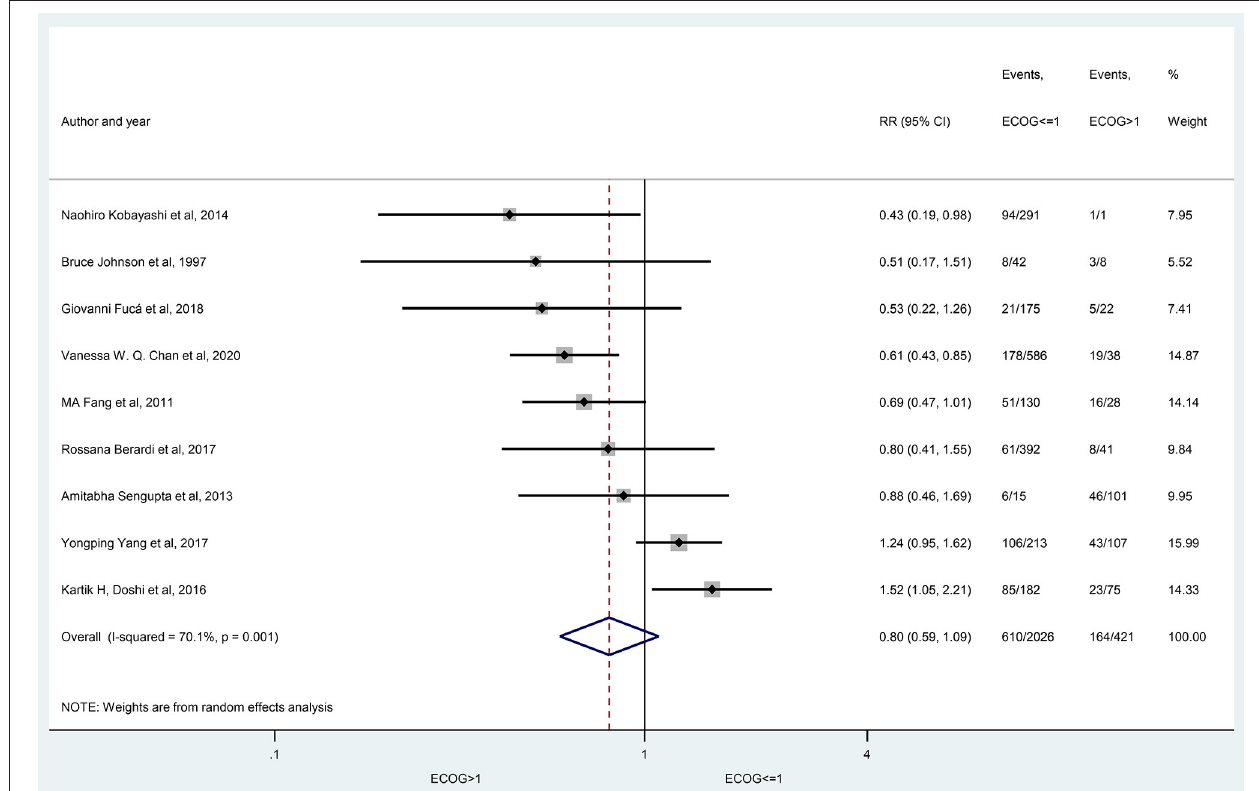
FIGURE 5 | The prevalence of hyponatremia in patients with lung cancer having ECOG ≤ 1 and ECOG > 1 performance state. Black diamonds represent the individual effects of studies, and vertical lines show the corresponding 95% CI. The size of the gray squares reflects the individual weight of a particular study. The blue diamond shows the overall or summary effect. The outer edges of the diamonds represent the CIs. ECOG, Eastern Cooperative Oncology Group performance status, RR, risk ratio.